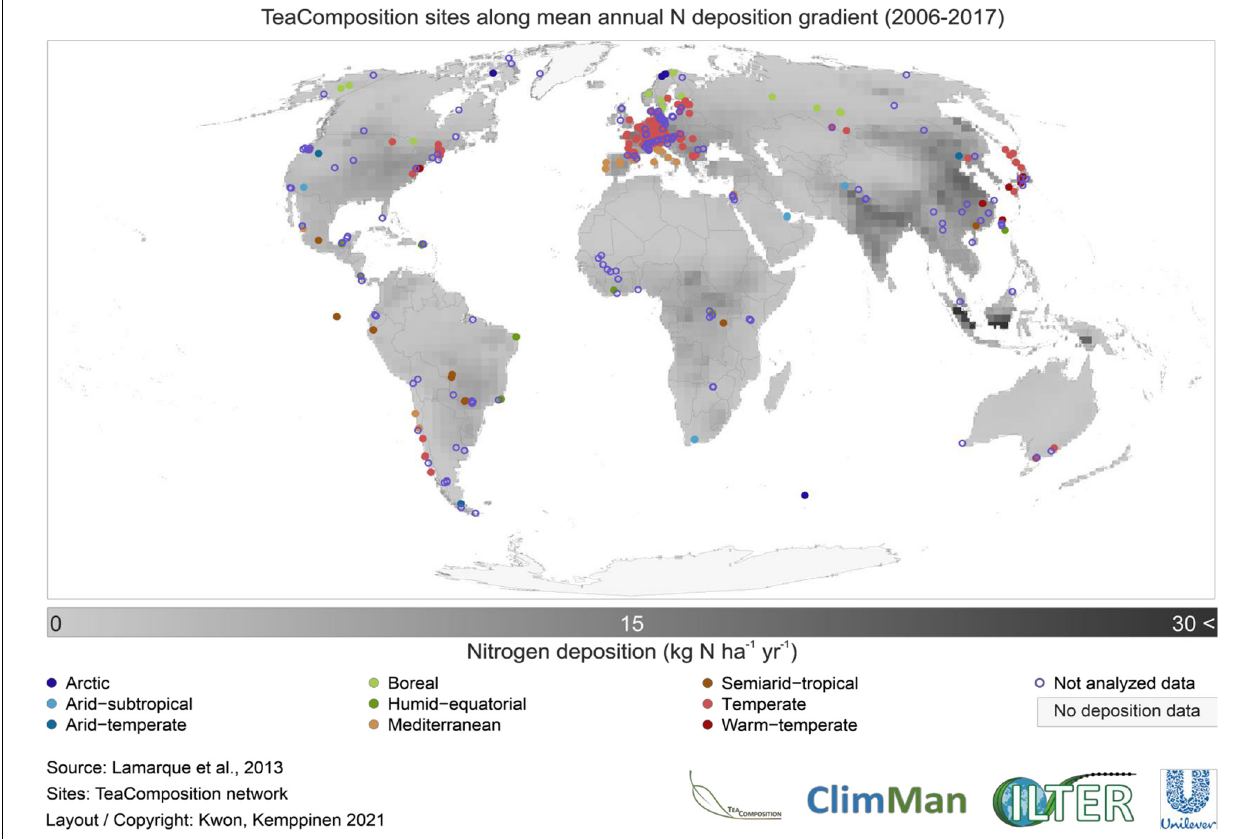
FIGURE 1 | Map showing the mean annual nitrogen deposition during 2006–2017 period and the location of the study sites within TeaComposition initiative. Data from the 524 colored sites have been used in the present study. Colors of each site depict biomes classified according to Walter and Breckle (1999). See Table 1 and Supplementary Table 1 for more detailed information of